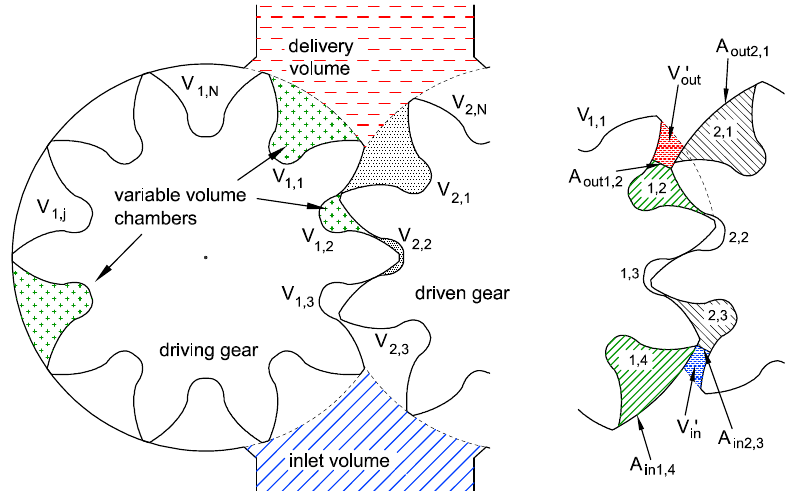
Figure 7. Definition of the control volumes in an external gear pump with the SC method